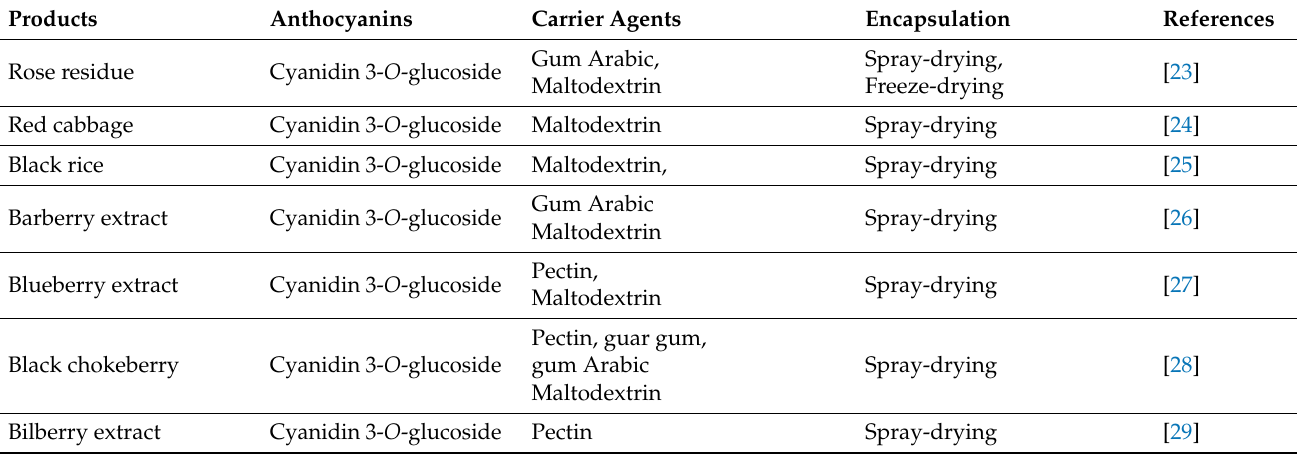
Table 3. Characteristics of different nano/microencapsulation processes used to protect cyanidin 3- O